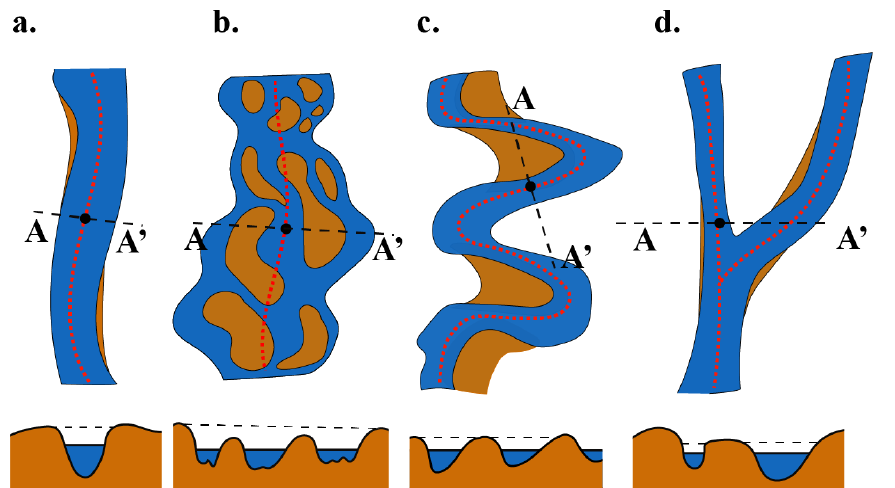
Figure 2. Cross sections (A–A’) of different stream geometries in profile view. The straight streams ( a ) typically exhibit clear inflection points on either sides of the stream. The diagram shows the active channel in blue, the stream centerline dashed in red, and the cross section dashed in black. Braided ( b ), meandering ( c ), and streams that intersect ( d ) can have multiple inflection points making it more difficult to identify stream boundaries. ( a ) Straight: If stream boundaries exhibit a distinguishable slope (steep profile) cross section methods may succeed. ( b ) Braided: If multiple channels exist, current methods may fail due to multiple pairs of inflection points. ( c ) Meandering: if a cross section appears at an inner bend and intersects the stream at multiple locations on the stream, current methods may fail due to multiple pairs of inflection points. ( d ) Stream junction: if a cross section appears in a region with an adjoining stream and a cross section intersects both streams, current methods may fail due to multiple pairs of breaks in